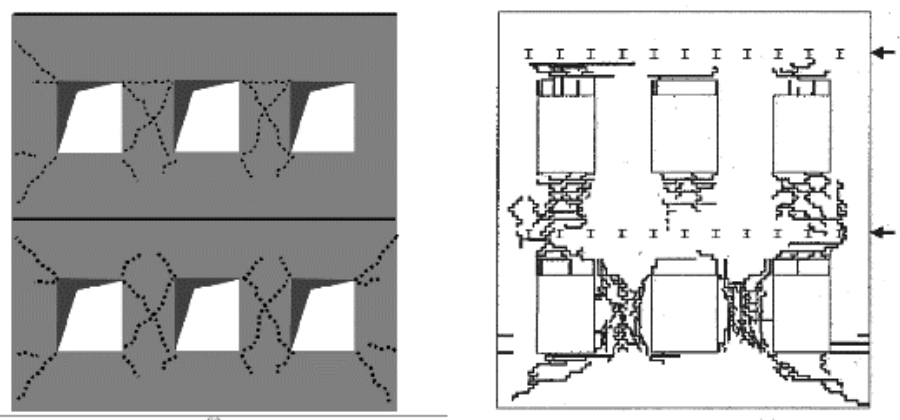
Figure 13. Expected vs. actual damage patterns for the considered URM wall. The first wall specimen considered for verification belongs to Ref [34]. The considered wall specimen has dimensions of 194 × 143 cm with 16 cm thickness and a window opening at its center, which has a dimension of 52 × 47 cm. As a URM wall, the compressive masonry wall strength f m = 11.7 MPa is reported, while the tensile strength of the material is taken as 5% of the compressive strength, which is f mt = 0.56 MPa. Under a vertical load of 41.2 kN, the maximum horizontal load was measured as 26.1 kN. The discretization of the damaged wall specimen under consideration is given in Figure 14.